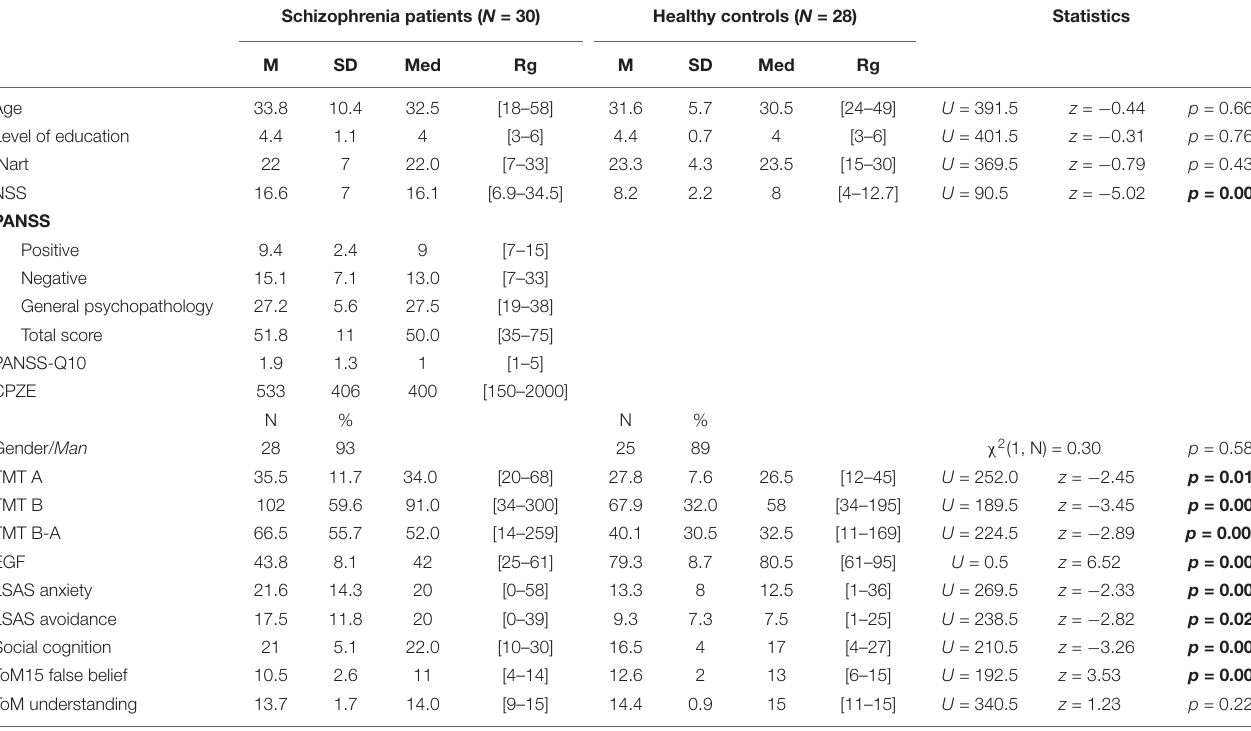
TABLE 1 | Socio-demographic description and mean, standard deviation, median and range of values are presented for the age, level of education, premorbid IQ (fNART), neurological soft signs (NSS), positive and negative symptom scale (PANSS), medication (chlorpromazine equivalent dose CPZE in mg/day), gender, trail